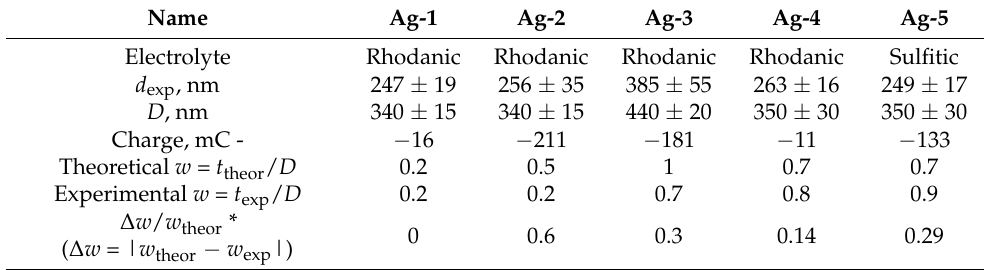
Table 3. Characteristics of silver inverse opals (exp.—experimental values measured on the SEM im- ages or calculated according to the experimental data, theor.—theoretical values-calculated according to Faraday’s laws of electrolysis under the assumption that the direct opal matrix had no